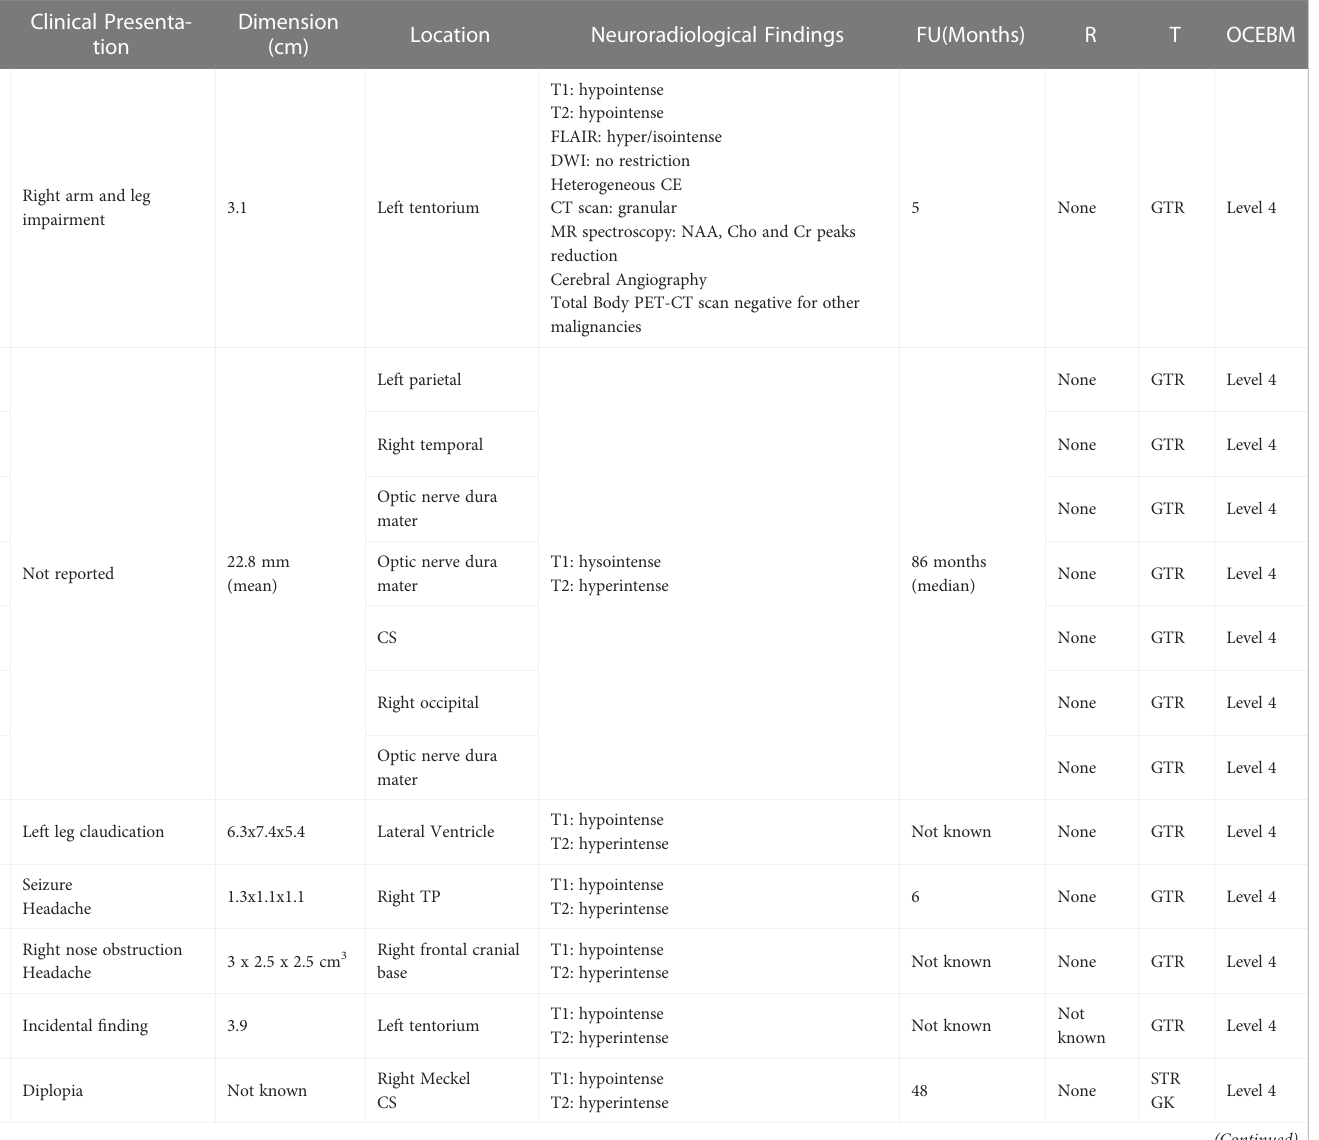
TABLE 1 Literature Review